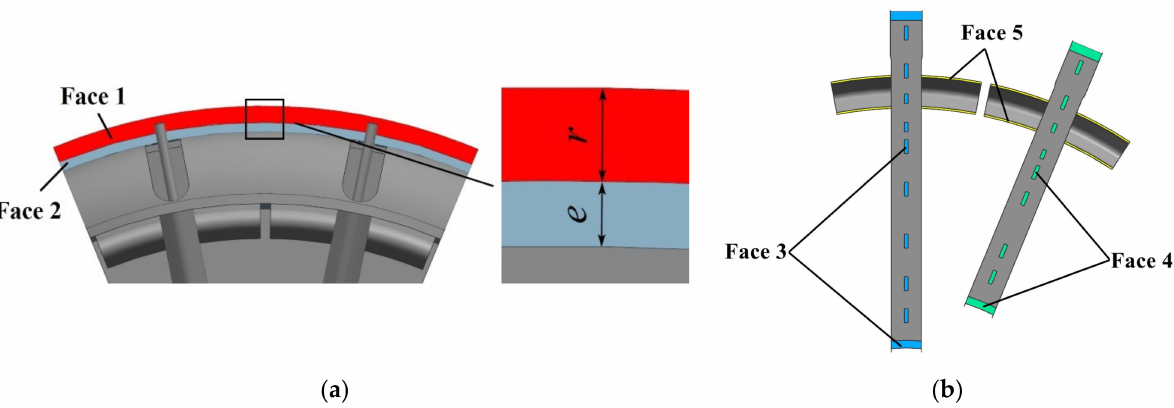
Figure 4. Schematic diagram of feature faces: ( a ) heat shield inlet and afterburner annulus; ( b ) outlet of radial and circumferential